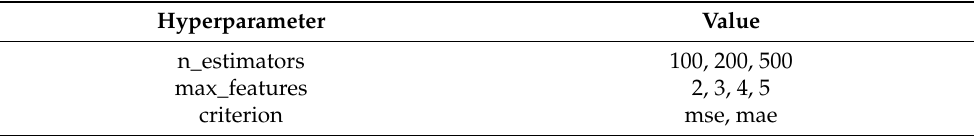
Table 3. Hyperparameters to determine the optimal values for random forest regressor.